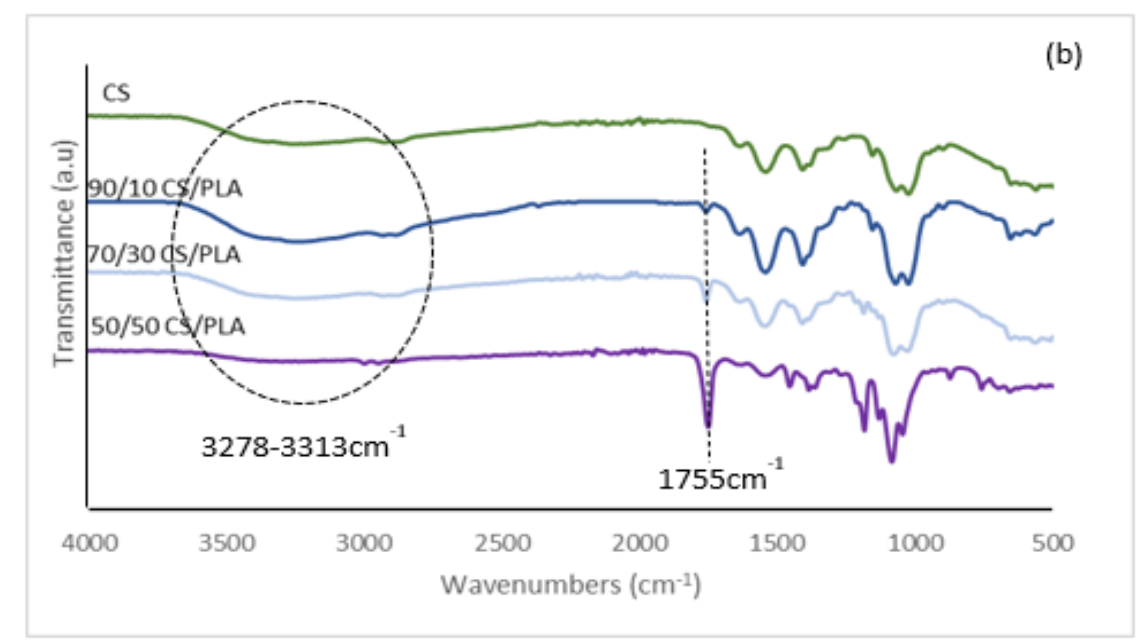
Figure 1. FT-IR spectrums of ( a ) PLA and CS/PLA with GO, and ( b ) CS and CS/PLA without GO composites.